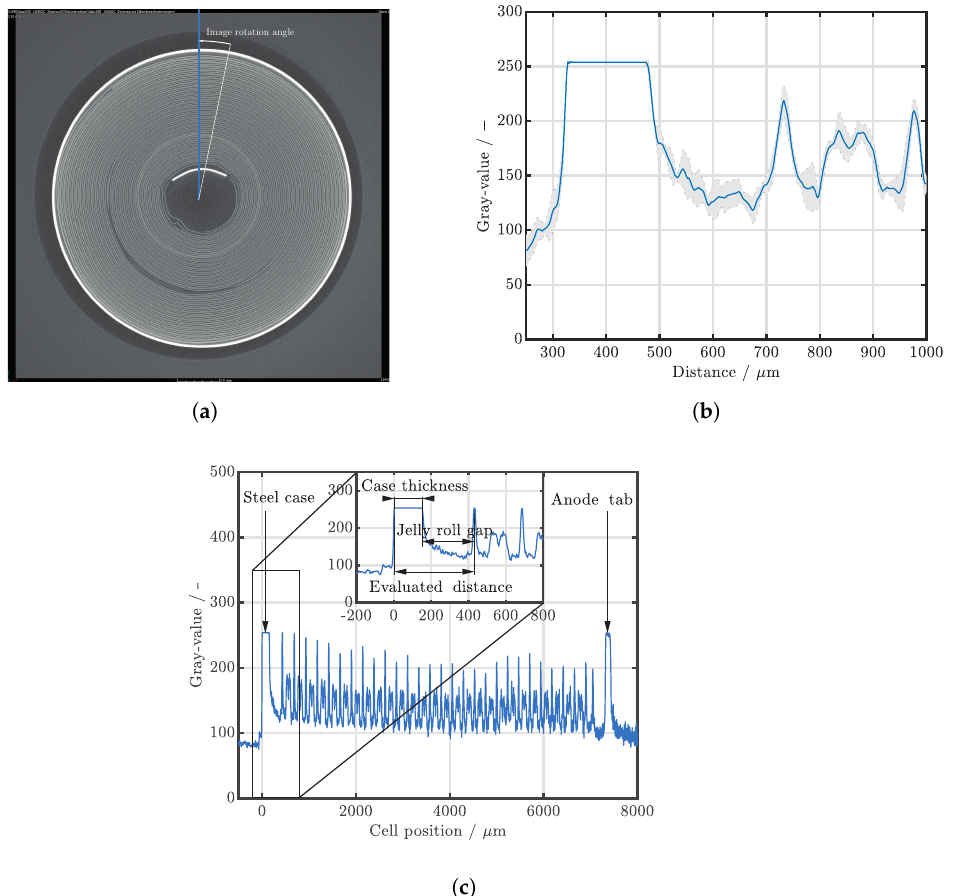
Figure 2. Gray-value analysis of a CT image of a Samsung INR18650-25R cell. Materials with high atomic numbers and density, such as the iron in the steel case and the copper of the anode current collector, have high radiation absorption and therefore exhibit higher gray-values in this evaluation. ( a ) CT image with 20 evaluated parallel lines marked in blue. As every line has a width of only one pixel, these 20 lines appear as a single line in this image. The rotation direction and angle of the image are also marked. ( b ) Gray-values and standard deviations for 20 evaluated lines along one angle in the case region. ( c ) Gray-values along the evaluated lines of the top half of the